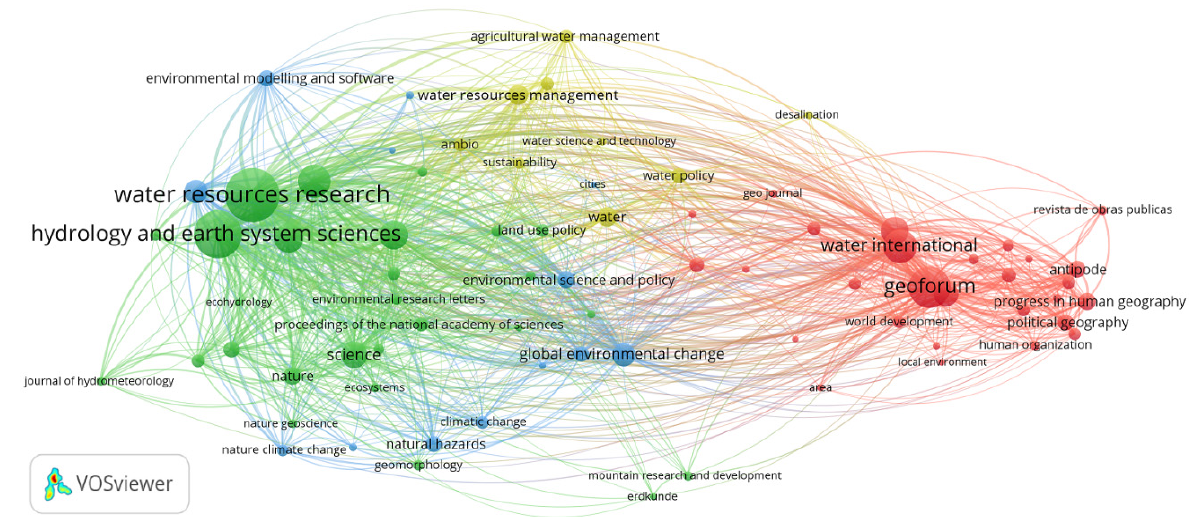
Figure 10. Scientific source co-citation network of socio-hydrology.